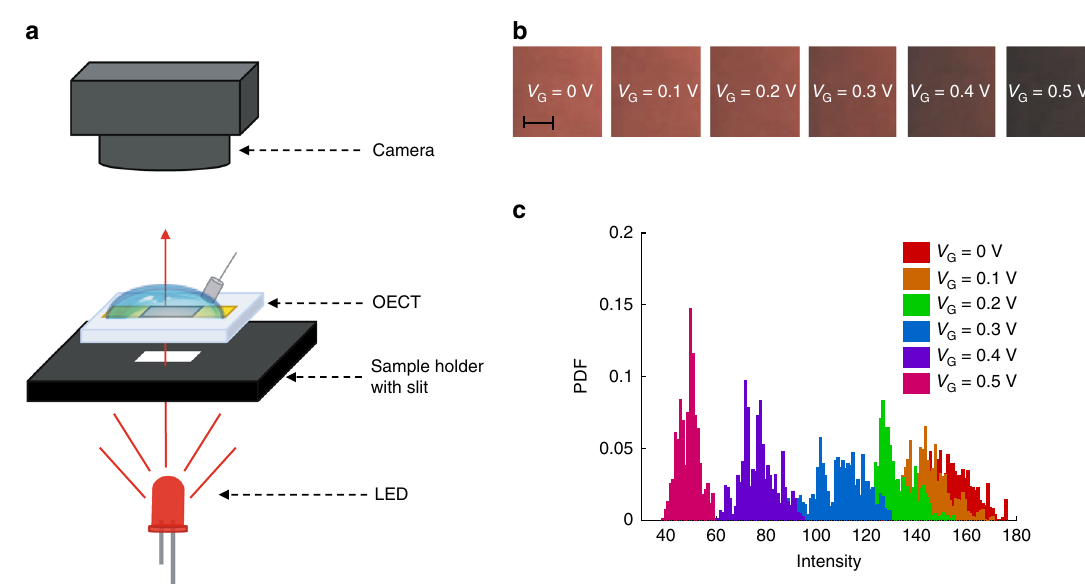
Fig. 7 Electro-optical characterization of OECTs. a Schematic of the measurement setup. b 2D intensity maps measured on an OECT with PEDOT:PSS/ PLL = 5/1 at V G = [0, 0.1, 0.2, 0.3, 0.4, 0.5] V and V D = V S = 0 V. The scale bar is 50 µ m. c Probability density function (PDF) of the 2D intensity maps